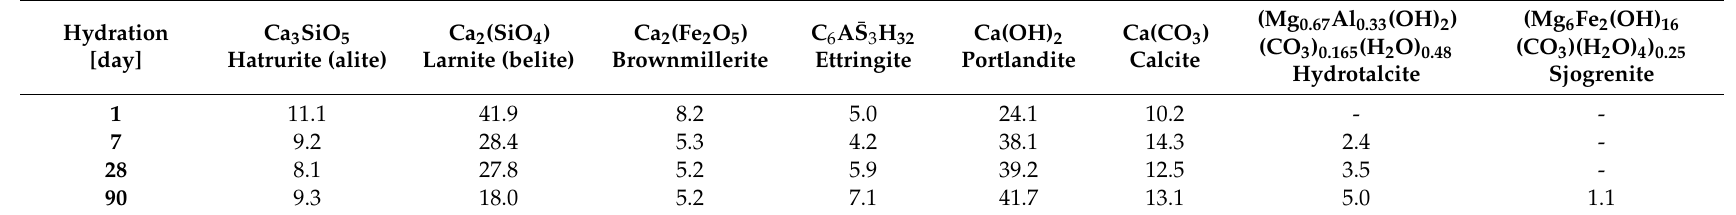
Table 3. Mineral composition of reference sample with cement and ground blast furnace slag (GBFS).